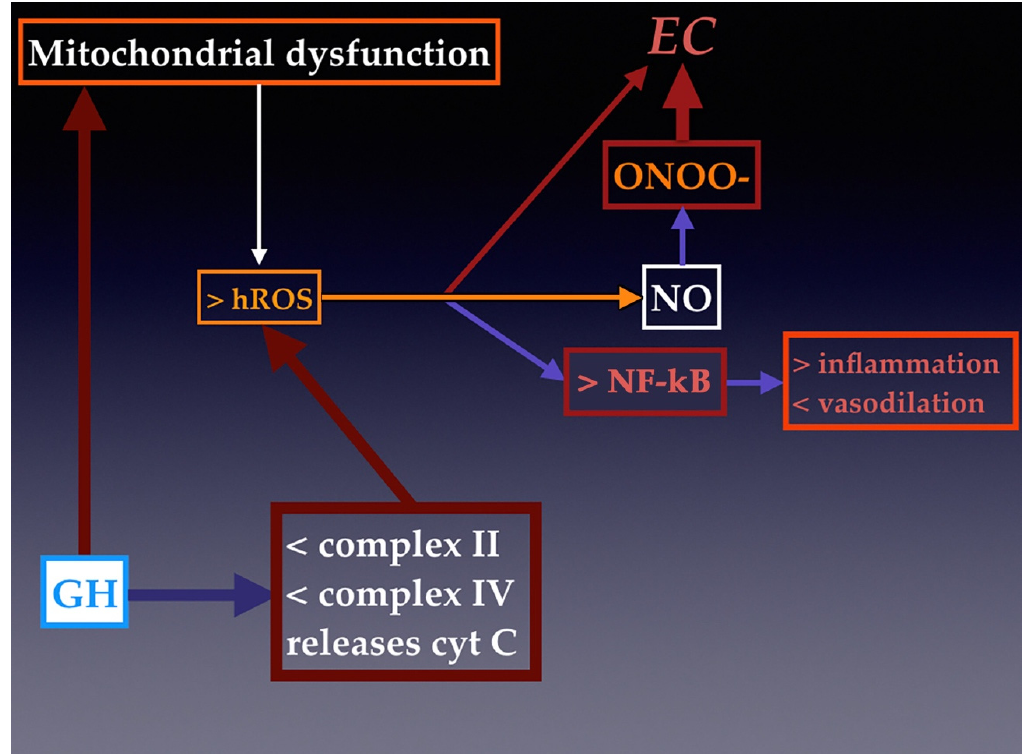
Figure 2. Mitochondrial dysfunction leads to vascular endothelium senescence. An excessive production of highly reactive oxygen species (hROS) by mitochondria induces the elimination of NO, because it is transformed into peroxynitrite (ONOO – ), which is toxic for endothelial cells. Moreover, the excessive oxidative stress induces the activation of nuclear factor-kappa B (NF-kB), which increases the expression of inflammatory genes in the blood vessels and decreases vasodilation. These lead to the presentation of a senescent phenotype in the endothelial cells. GH administration corrects mitochondrial dysfunction, because GH is able to enter to mitochondria and decrease the activity of complexes II and IV of the mitochondrial respiratory chain. In addition, GH produces a decrease in the mitochondrial membrane potential which translates into the release of cytochrome C (cyt C) to the cytosol. Blue arrows: stimulation. Red arrows: inhibition or damage (in endothelial cells). Orange arrow: indicates that an increase in hROS induces the transformation of NO into ONOO - .